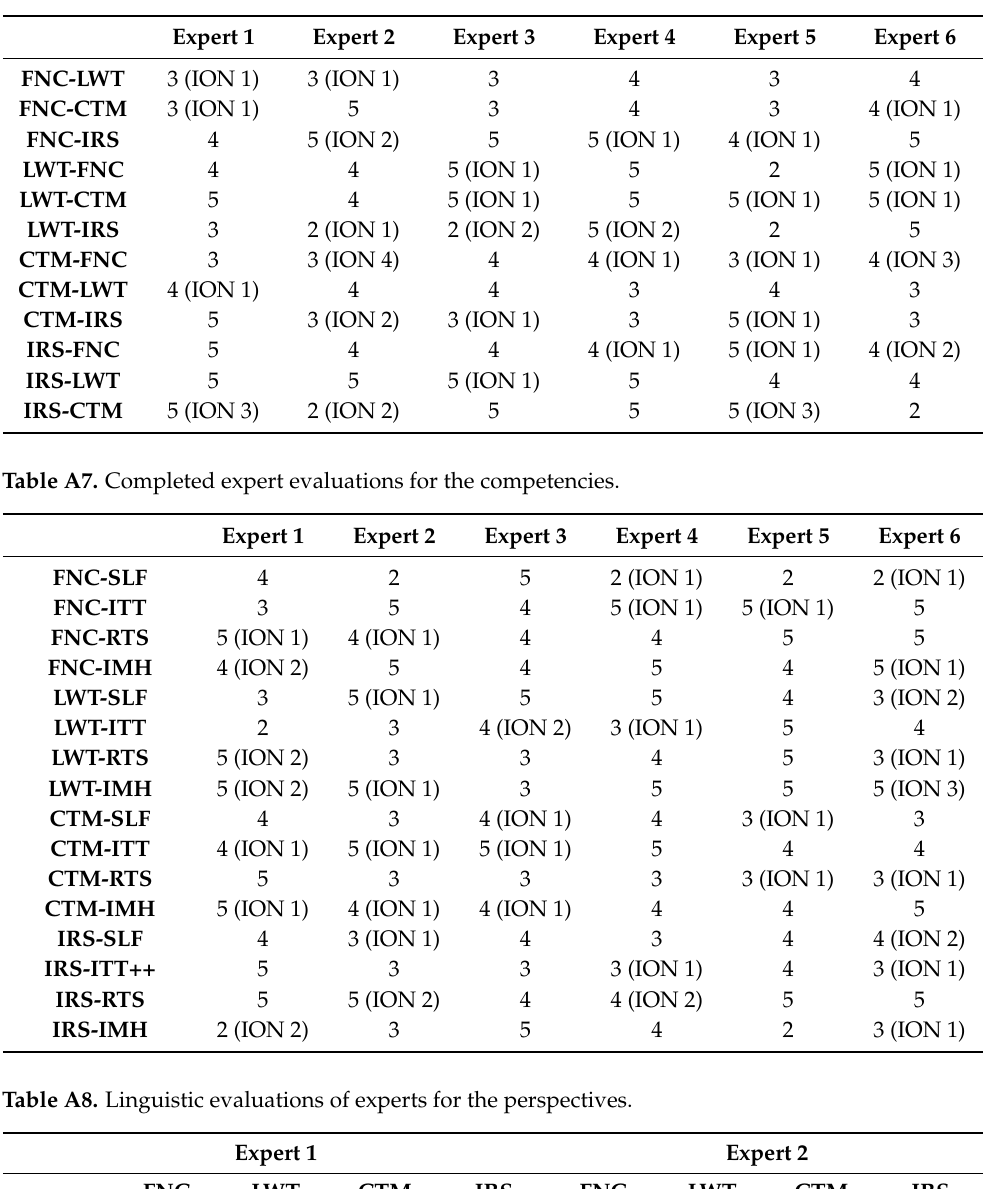
Table A6. Completed expert evaluations for the perspectives.